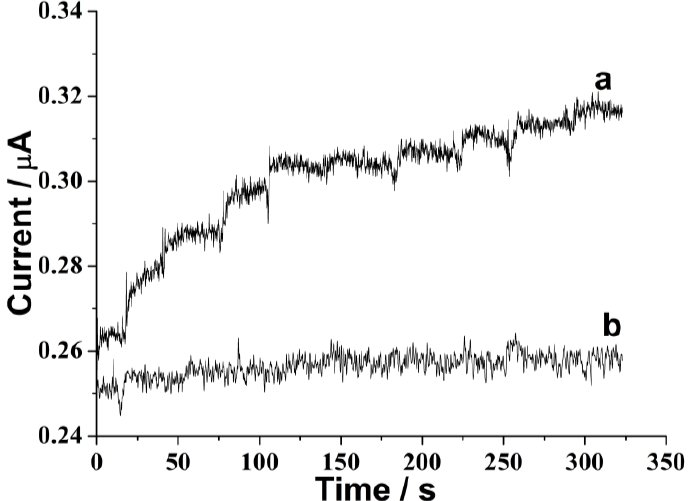
Figure 2. Chronoamperomograms obtained at ( a ) XOD/DNA and ( b ) DNA modified electrode in 0.1 M pH 7.4 phosphate buffers with injecting 200 μM 6-MP every 30 s. The detection potential was −730